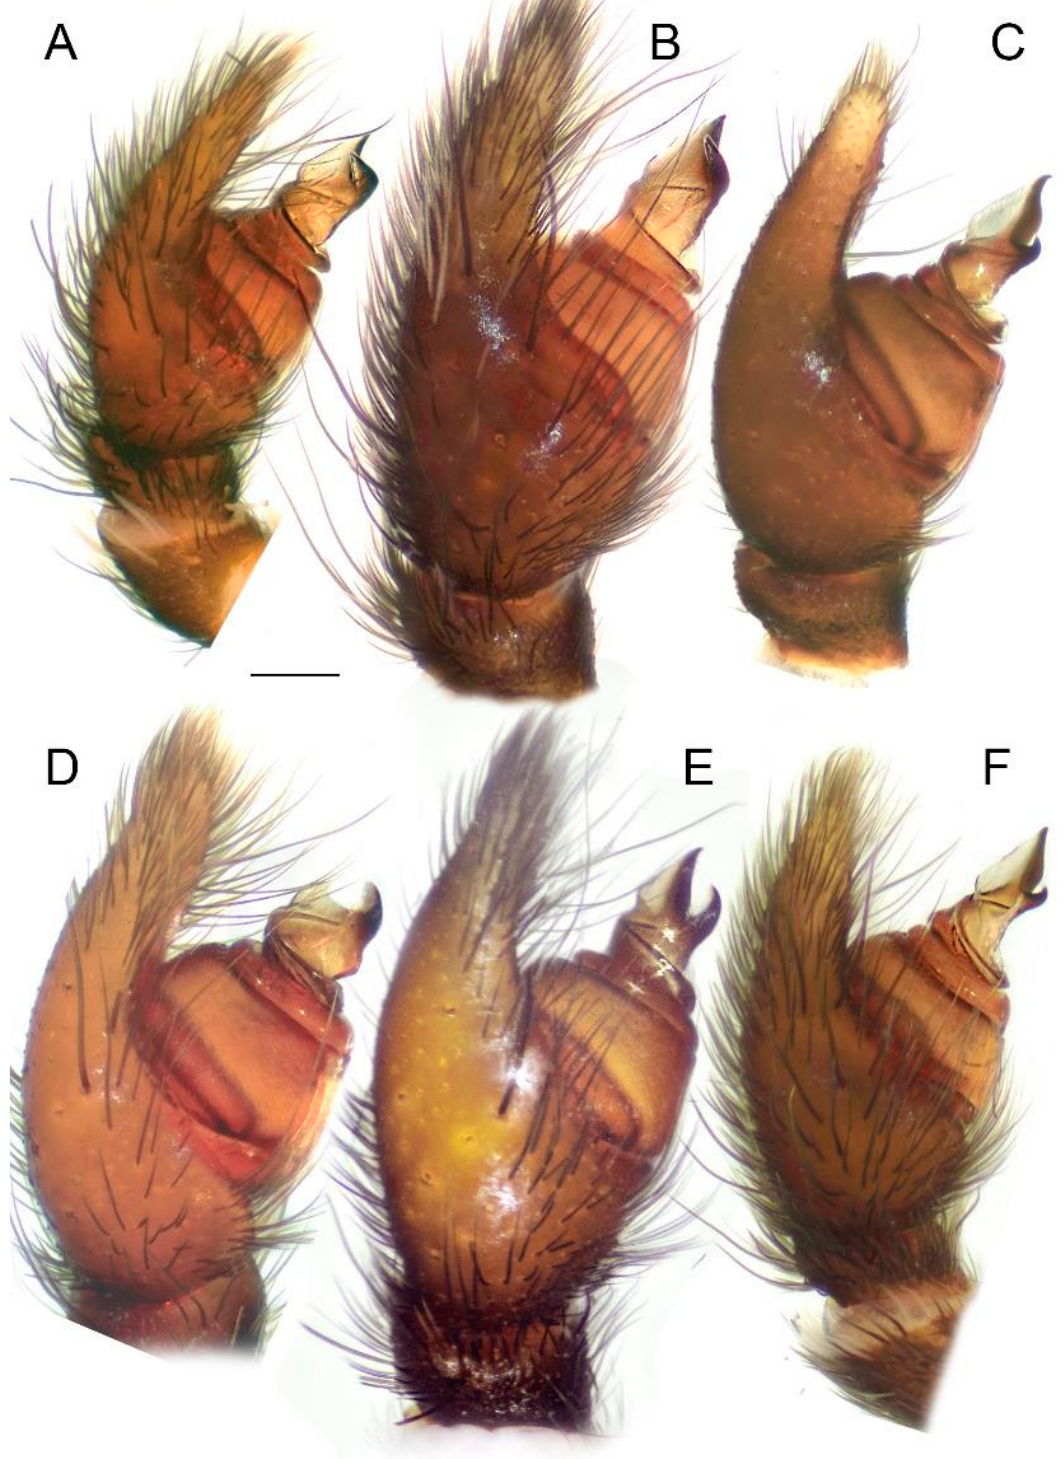
Figure 8. Male palps of five species of Loureedia ( prolateral view). A L. phoenixi ; B L. jerbae ; C L. annulipes ; D L. maroccana , holotype (after conductor was broken); E L. maroccana , holotype (conduc- tor still intact); F L. colleni . Scale bar: 0.25 mm.